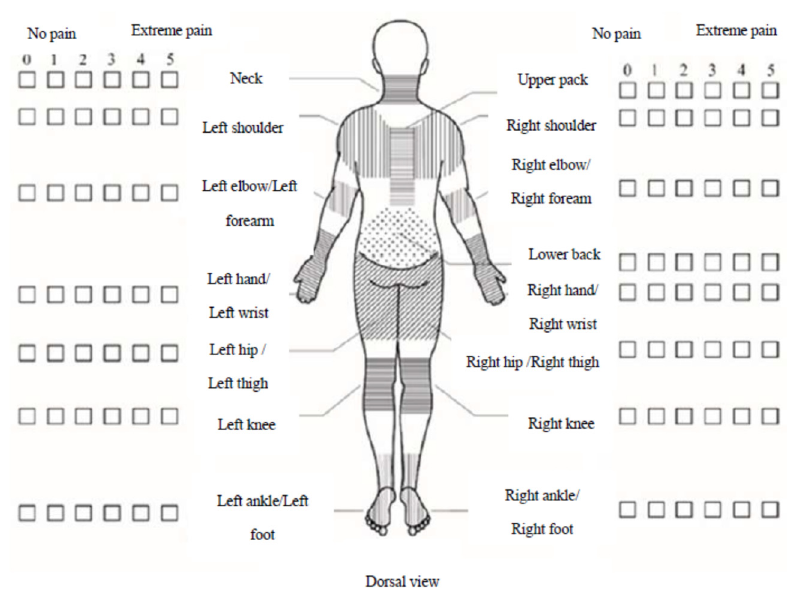
Figure 1. Modified Nordic Scale.